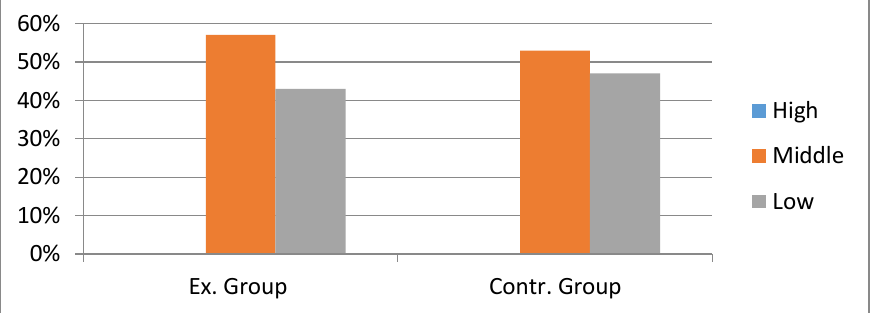
Figure4. Self-evaluation chart concerning the readiness to plan logopedic activities, selection of content and training techniques at ascertaining stage of